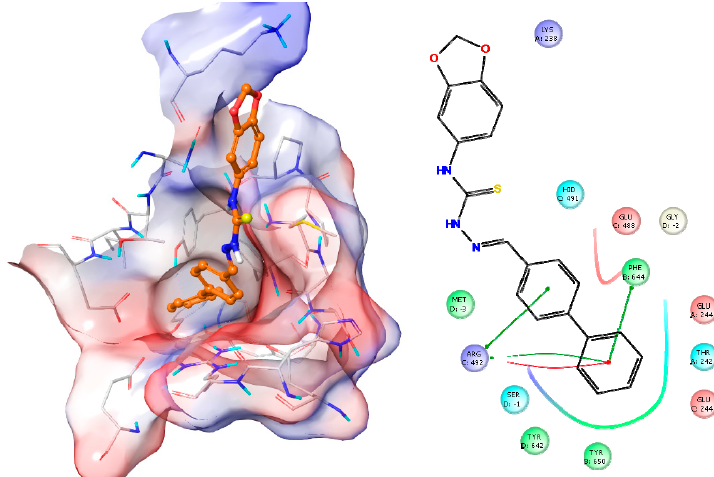
Figure 7. The docking position of compound 5 on SIRT1 and the interactions between compound 5 and SIRT1. (Green line: Pi-pi stacking; Red line: Salt bridge). Surface representation with overlaid electrostatic surface potentials (Red: Negative; Blue: Positive).